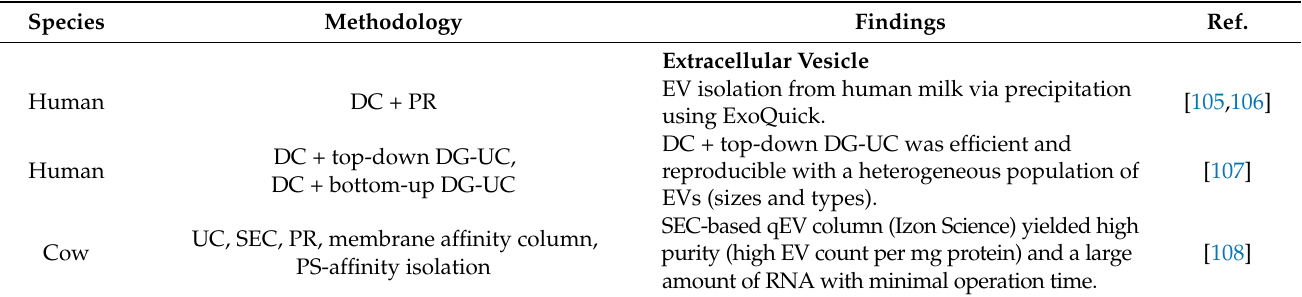
Table 3. Methods used to study EVs and exosomes from